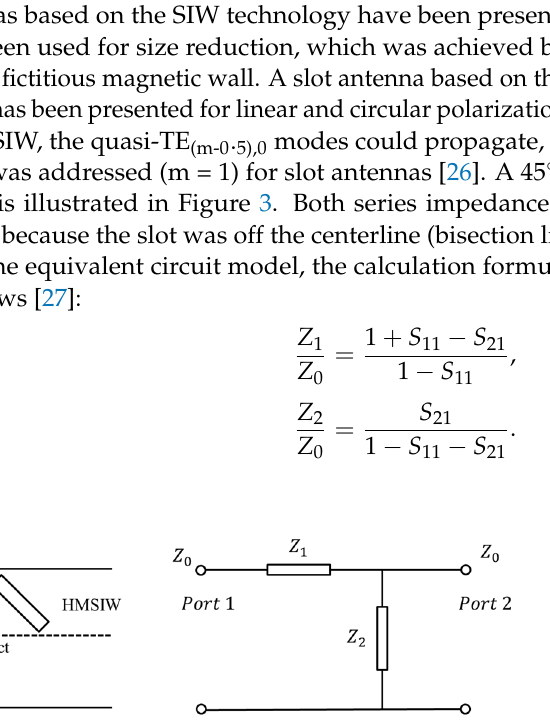
Figure 5. Surface current distributions with different phases for LHCP: ( a ) 0°, ( b ) 90°, ( c ) 180°, and ( d ) 270°.